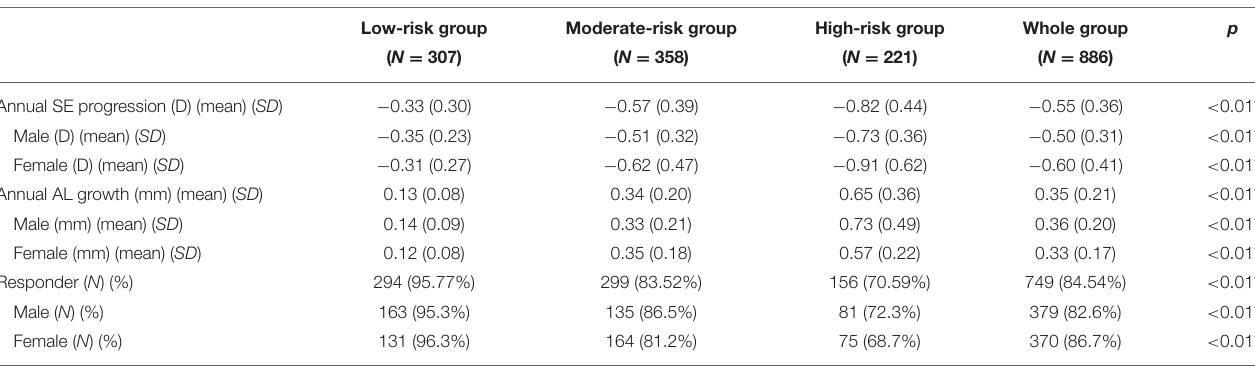
TABLE 3 | Study results of enrolled children in the second part of the